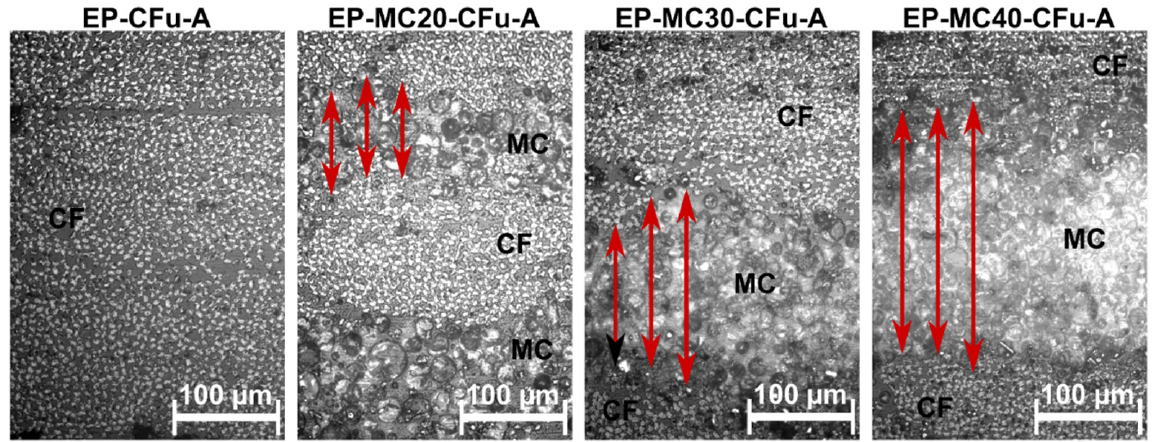
Figure 1. Optical microscope micrographs of the polished cross-section of the laminates EP-MCx-CFu-A. Red arrows indicate the thickness of the interlaminar region rich in microcapsules (MC) between two carbon fiber (CF) layers.